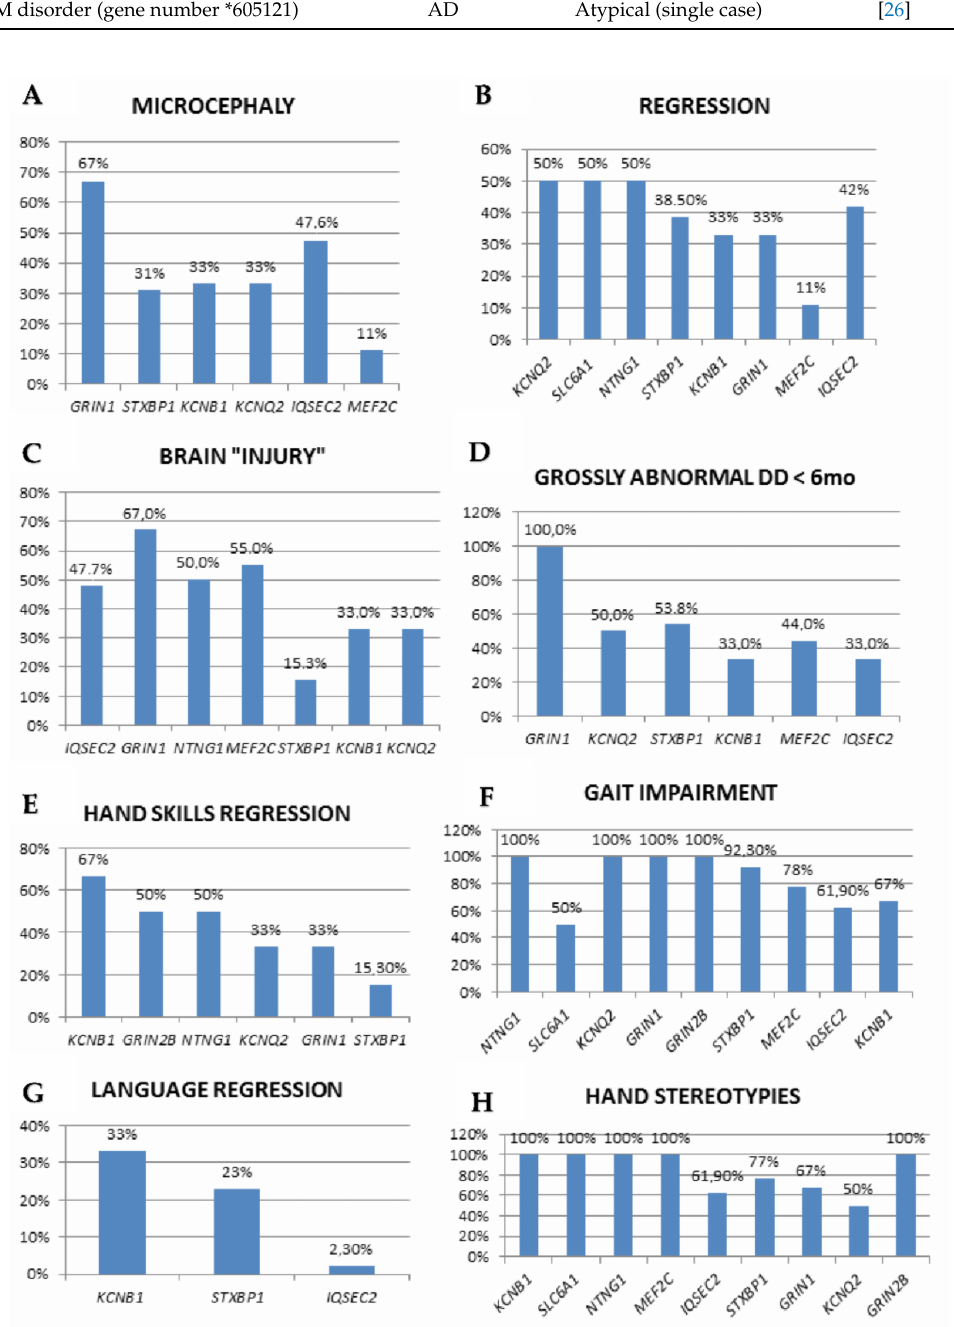
Figure 1. Neul’s inclusion and exclusion criteria applied to the reviewed cases according to genetic diagnosis (only genes with more than one reported case are shown), ( A – H ): microcephaly, regression, brain “injury”, grossly abnormal development in the first 6 months, hand skills regression, gait impairment, language regression, hand